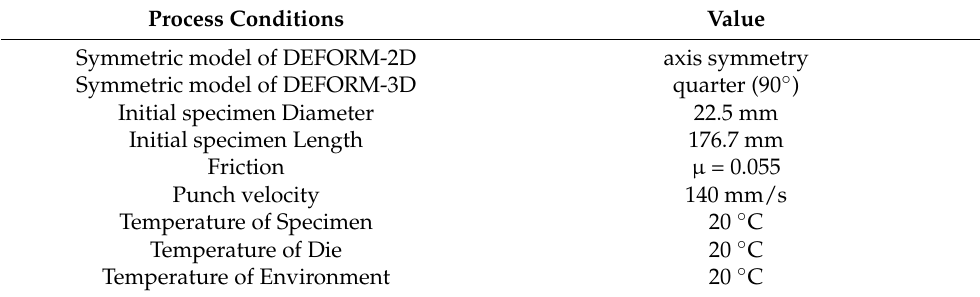
Table 3. Process conditions for the